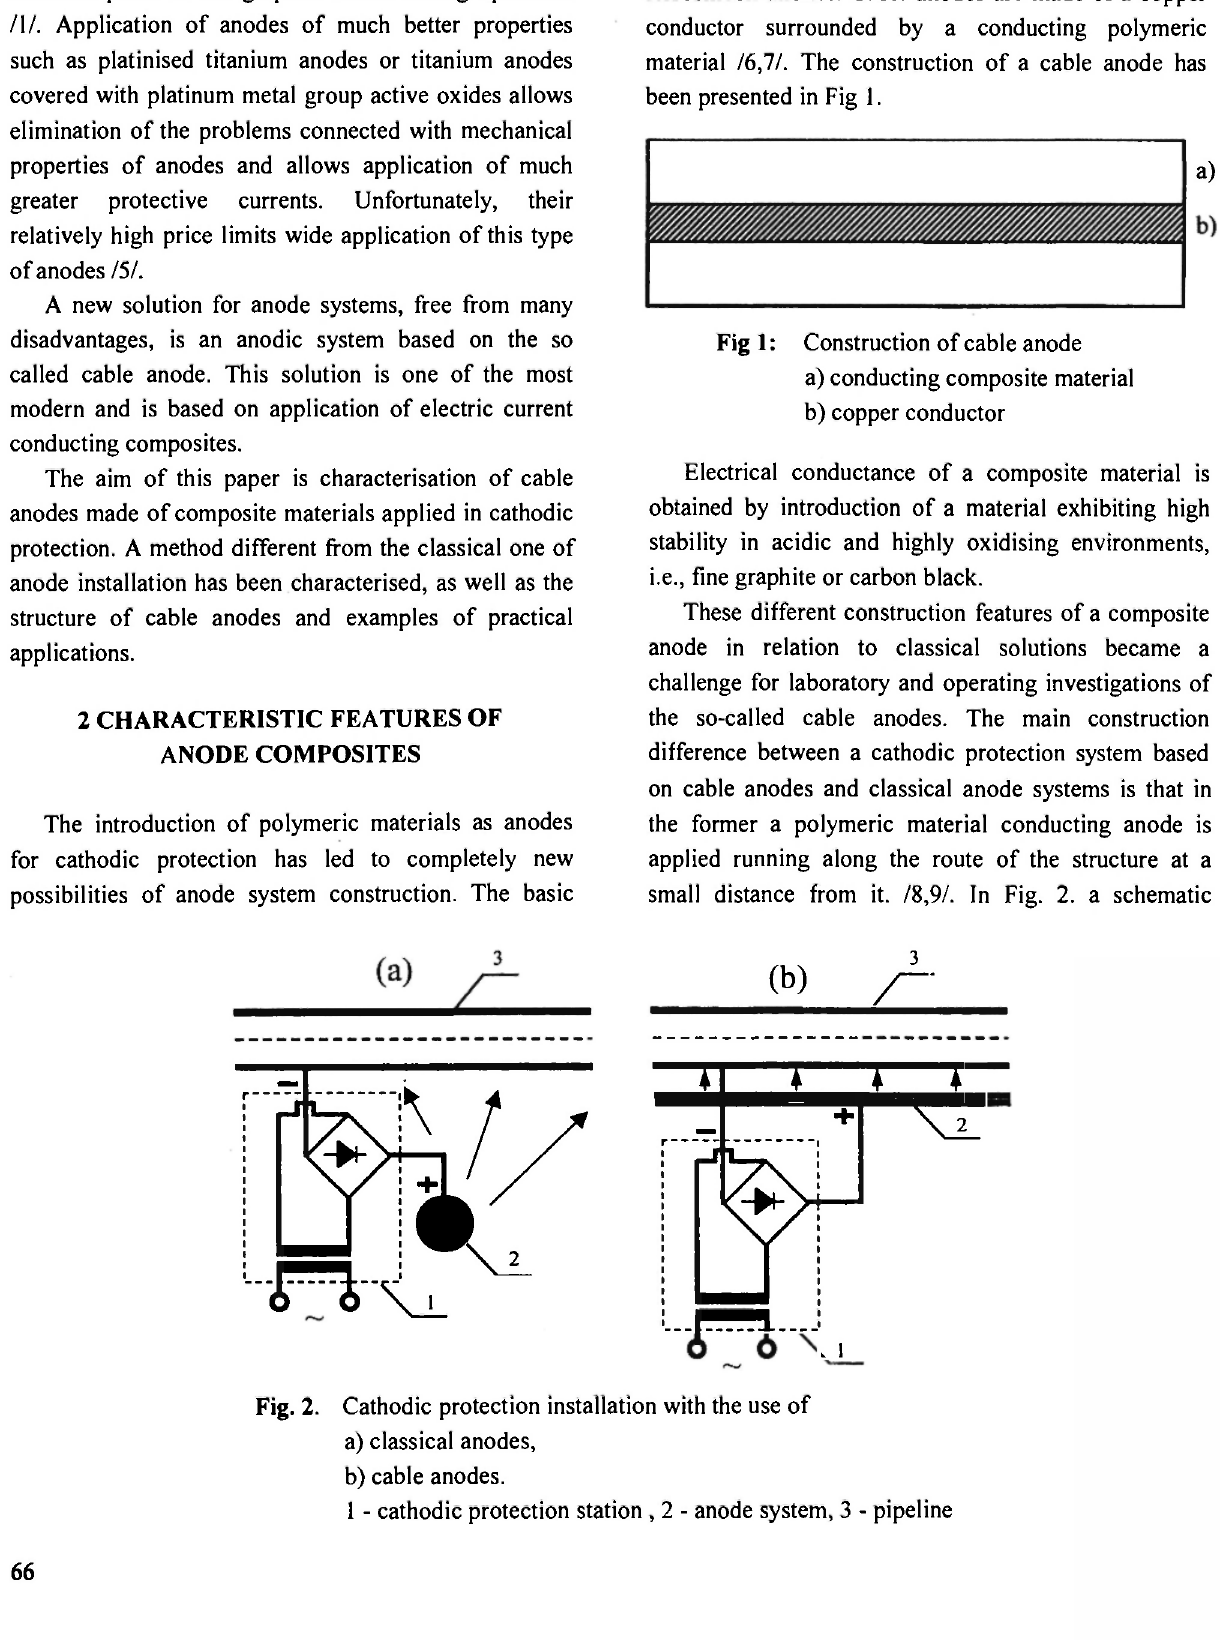
Fig. 2. Cathodic protection installation with the use of a) classical anodes, b) cable